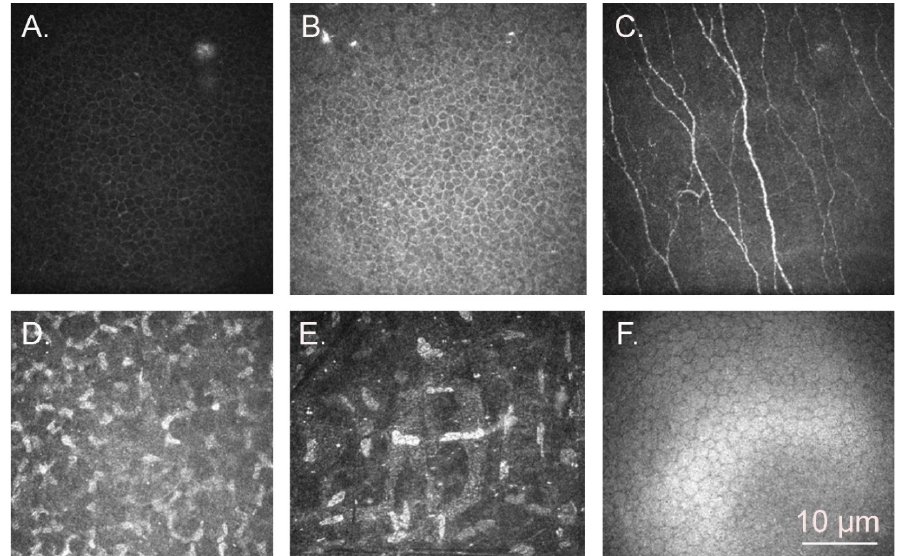
Figure A1. The cornea of a 38-year-old human ( Homo sapiens ) female, as imaged by confocal microscopy. ( A ) Superficial epithelium; ( B ) basal epithelium; ( C ) sub-basal nerve plexus in Bowman’s layer; ( D ) anterior stroma; ( E ) posterior stroma; ( F ) endothelium.